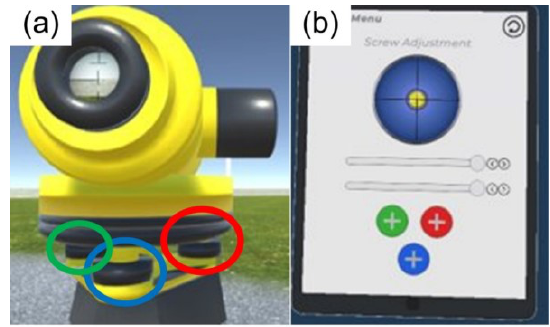
Figure 6. (a) virtual differential level instrument; (b) leveling menu for the differential level instrument. Note that tribrach screws are color-coded for ease of